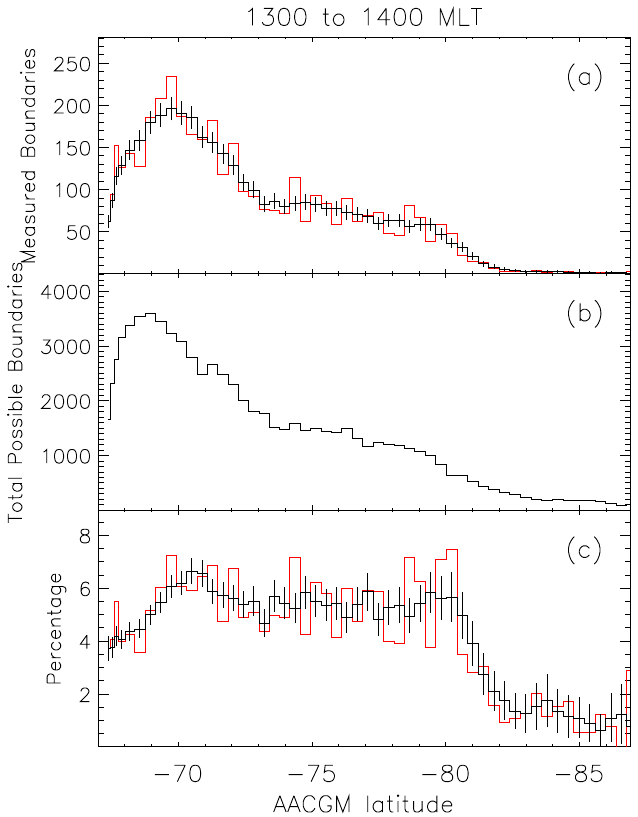
Fig. 11. The latitudinal variation of different boundary location statistics in the 13:00–14:00 MLT range: (a) The aggregate oc- currence distribution of observed boundary locations (red), and the same distribution smoothed by the application of a 5-range gate moving average (black). (b) The aggregate occurrence distribution of the total number of possible boundary identifications. (c) The probability distribution of observed boundary locations (red), and the smoothed probability distribution of observed boundary loca- tions